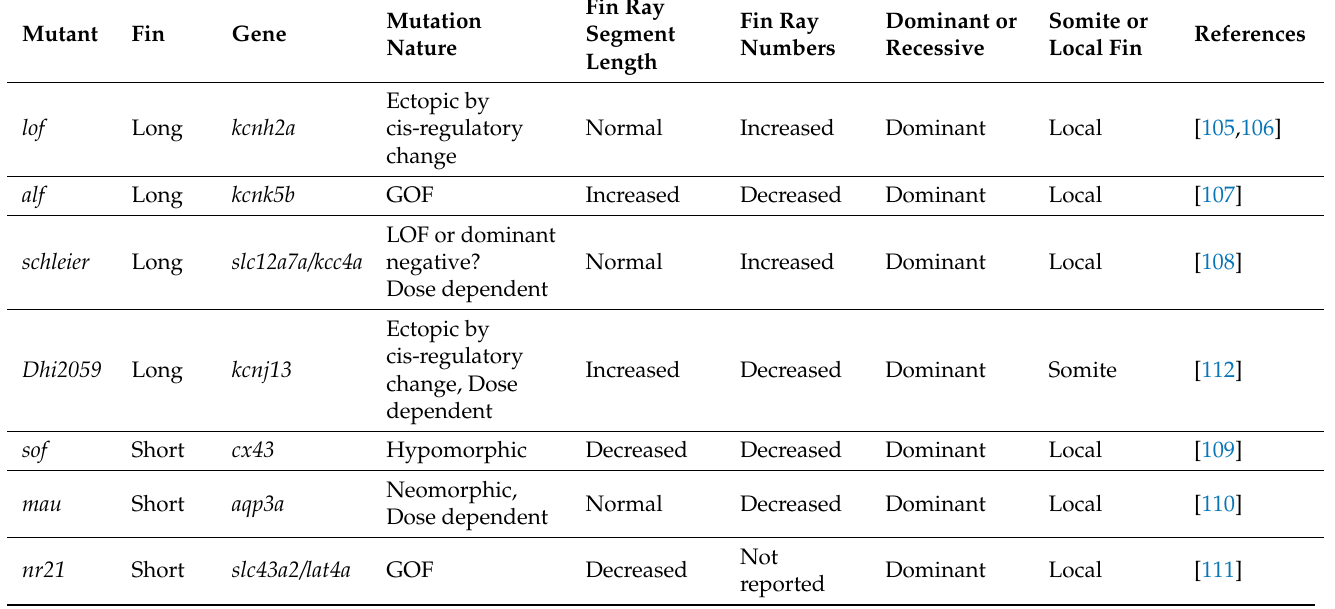
Table 2. Zebrafish, published fin-size